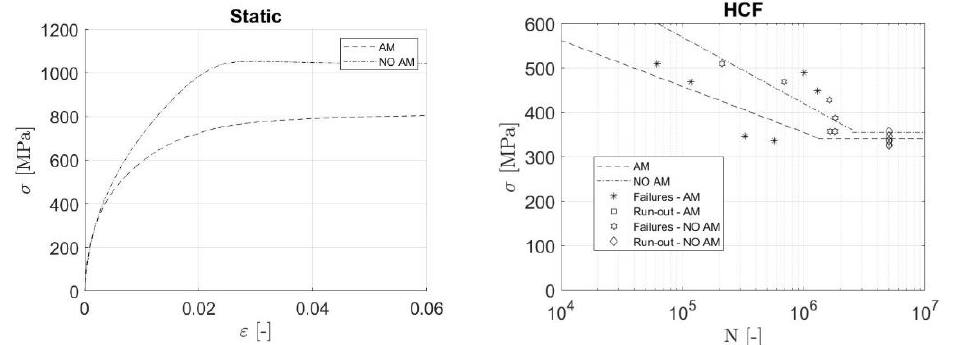
Figure 6. Quasistatic test results and monoaxial tensile fatigue test results [30].